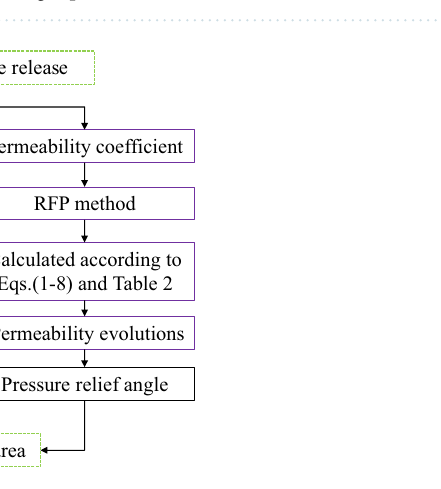
Figure 14. Distribution of the gas content ( a ) and residual gas pressure ( b ).